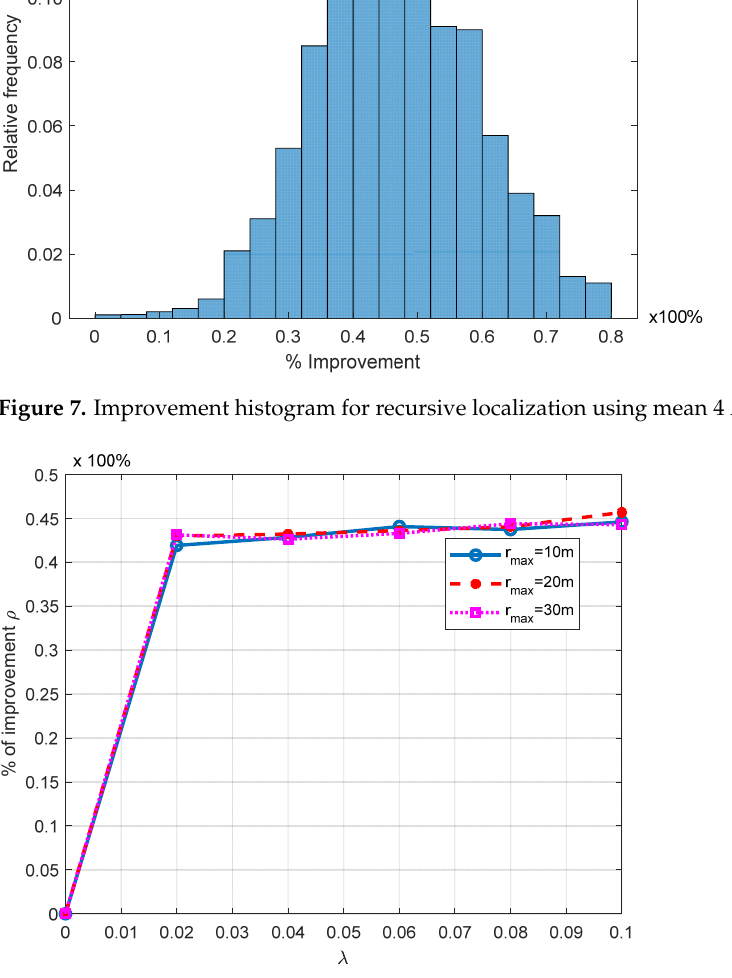
Figure 8. Performance improvement analysis of the RL algorithm for different r max .